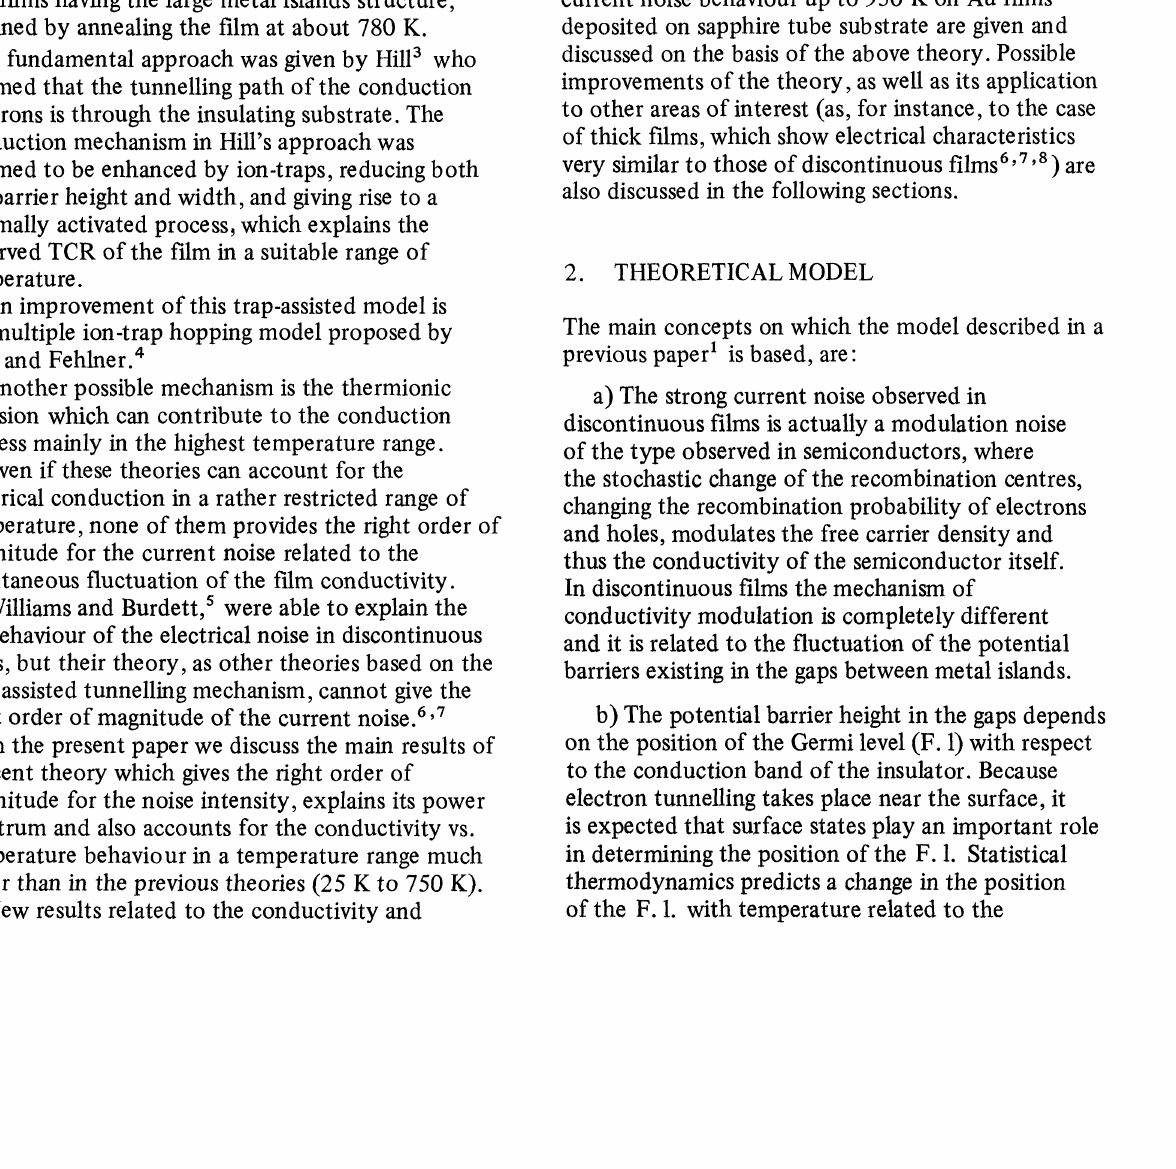
FIGURE Electron micrograph of discontinuous Au film on sapphire substrate after annealing at 780 K in vacuum 10 -9